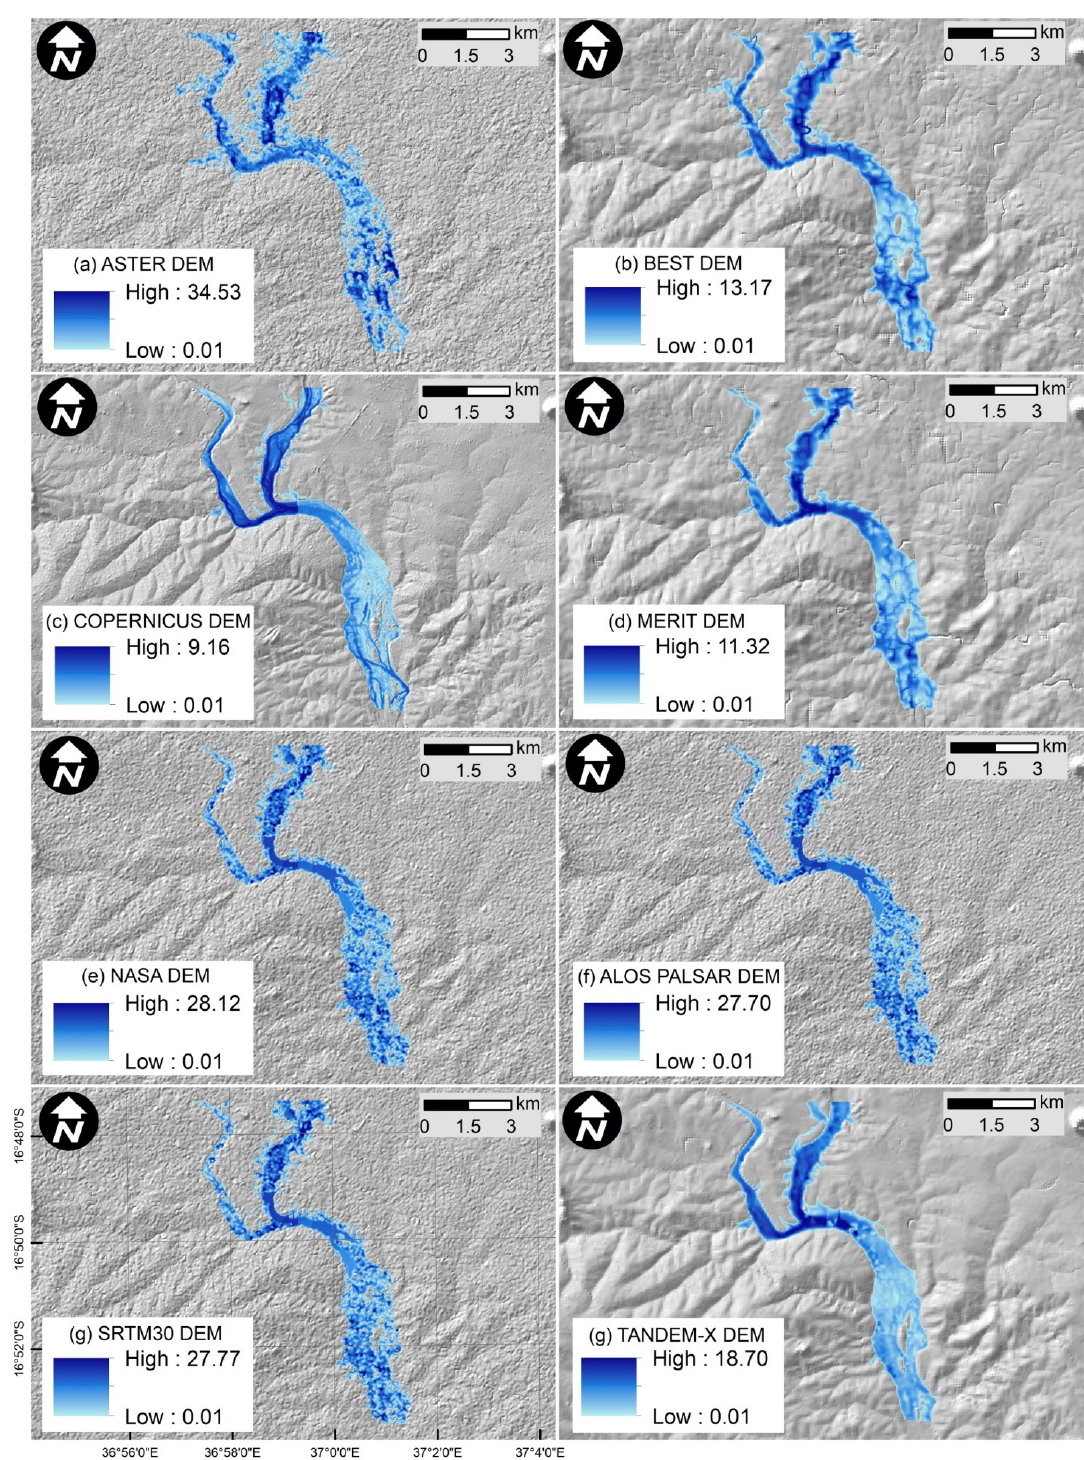
Figure 5. Flow depth results for the 500-year return period peak flow and each one of the free global DEMs used.